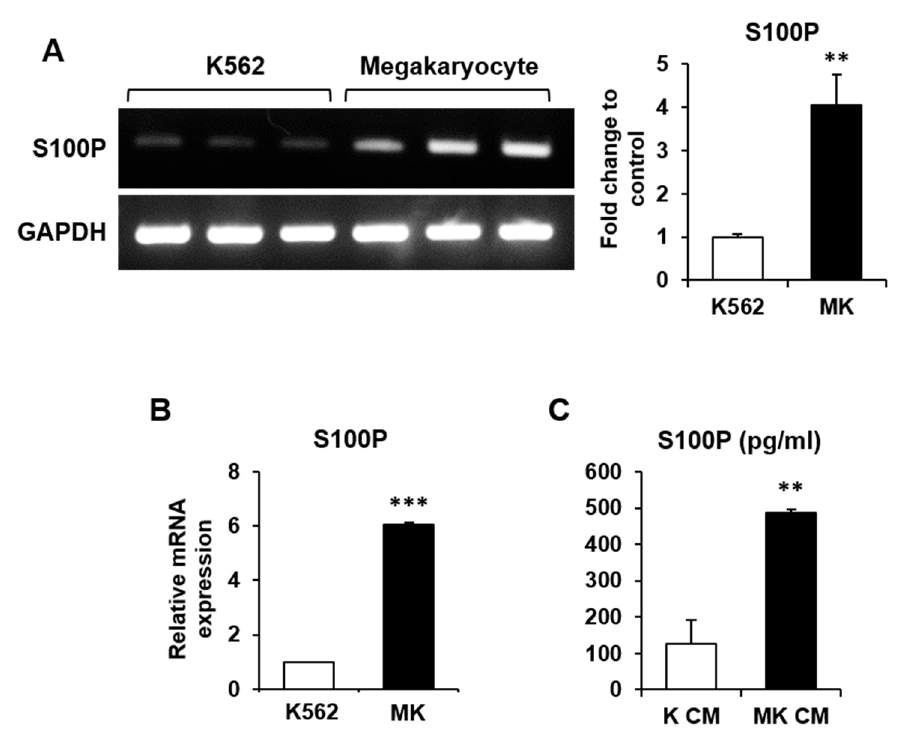
Figure 2. Validation of S100P expression in megakaryocytes (MKs) and MK-cultured conditioned medium (MK CM). ( A , B ) S100P mRNA expression in K562 and MKs detected by RT-PCR ( A ) and qPCR ( B ). The intensity of individual bands after RT-PCR ( A ) was determined using ImageJ software (NIH, Bethesda, MD, USA), and the data were normalized to the expression of Gapdh and calculated as a fold change relative to that in K562 cells, which was set to 1.0. **, p < 0.01. The relative mRNA expression level ( B ) was plotted against gene expression levels in K562 cells, which were set to 1.0. ***, p < 0.001. ( C ) Concentration of S100P protein in K CM and MK CM was determined by ELISA. **, p < 0.01 versus K CM.